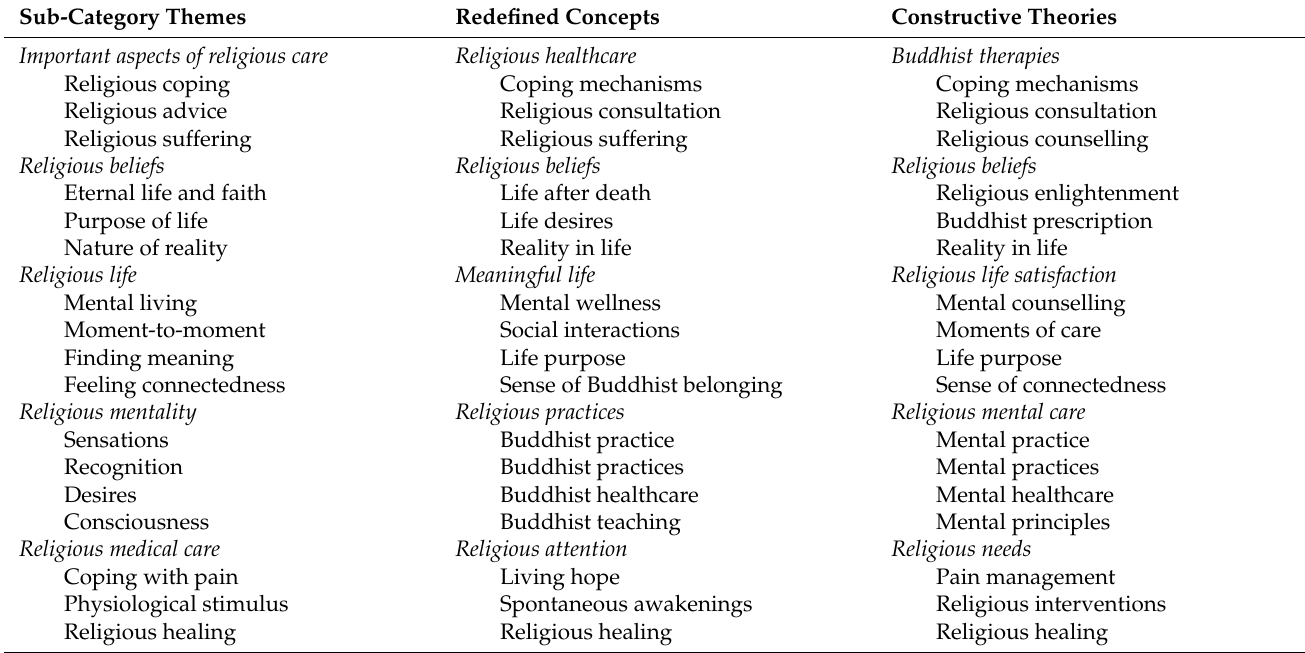
Table A4. Example of initial themes, redefined concepts, and constructive